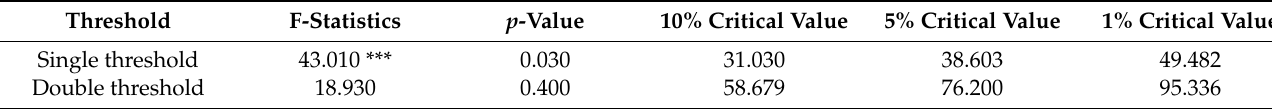
Table 3. The results of the tests for threshold effects.